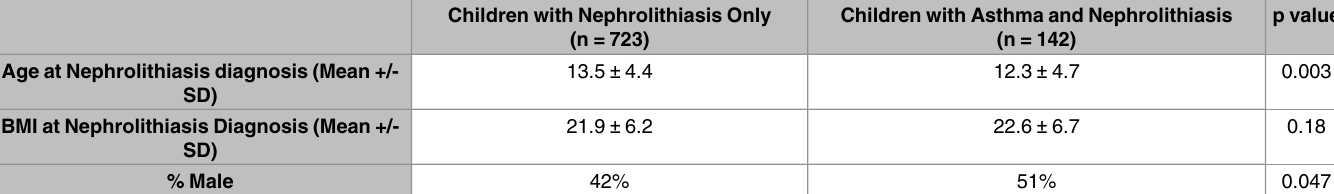
Table 2. Clinical-demographic data comparison between asthma-stone patients and stone patients without asthma.